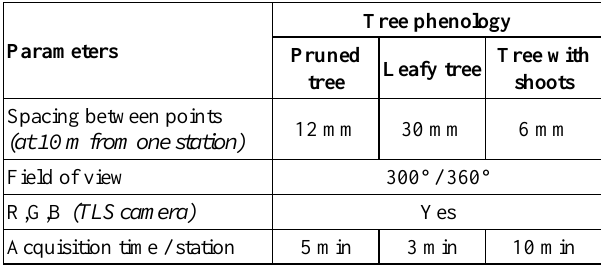
Table 5. Settings defined during laser scanning campaigns, for each phenological stage.